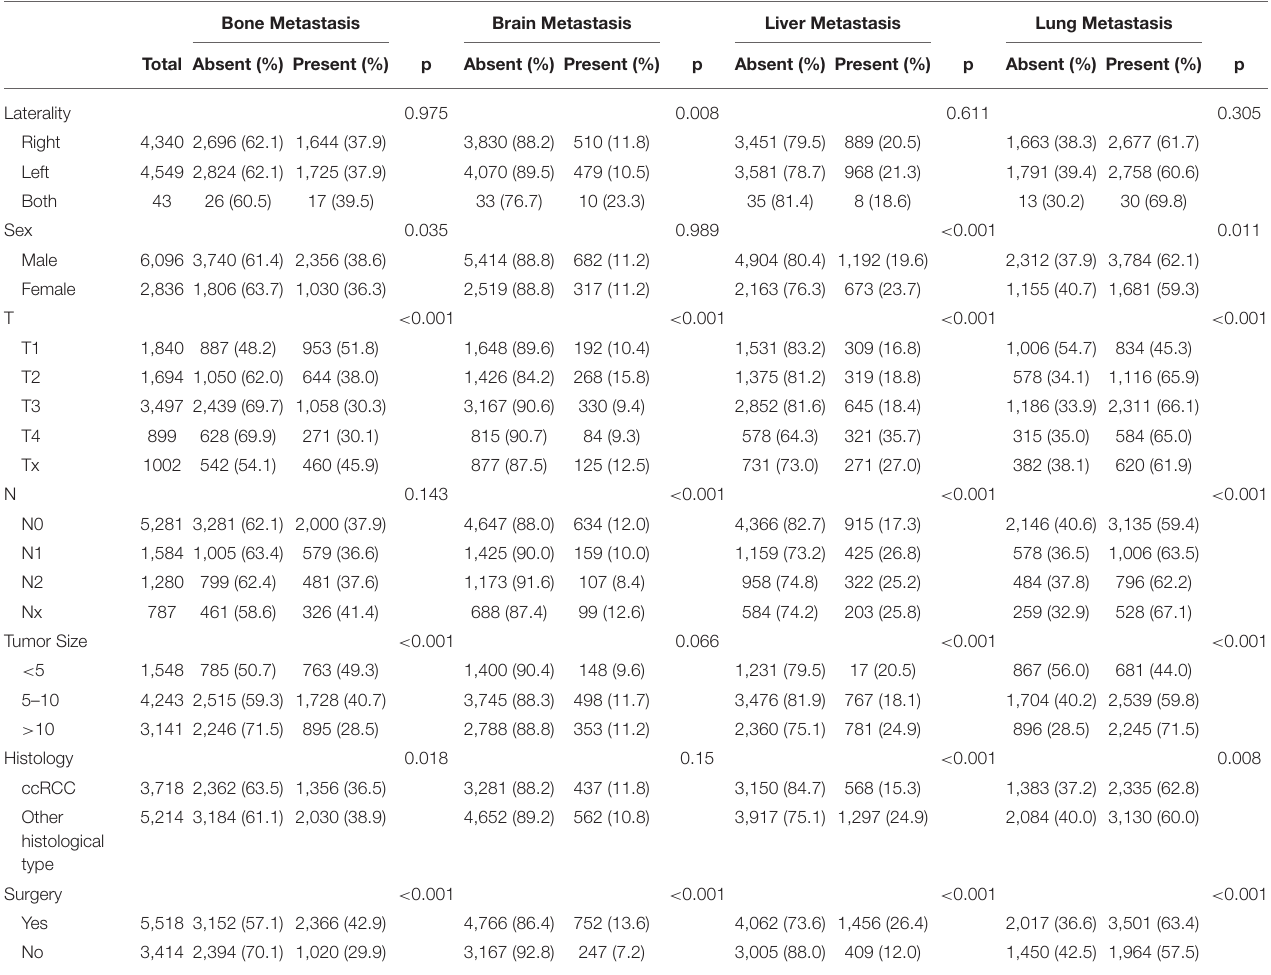
TABLE 2 | Characteristics of patients and metastatic organs of original cohort. Bone Metastasis Brain Metastasis Liver Metastasis Lung